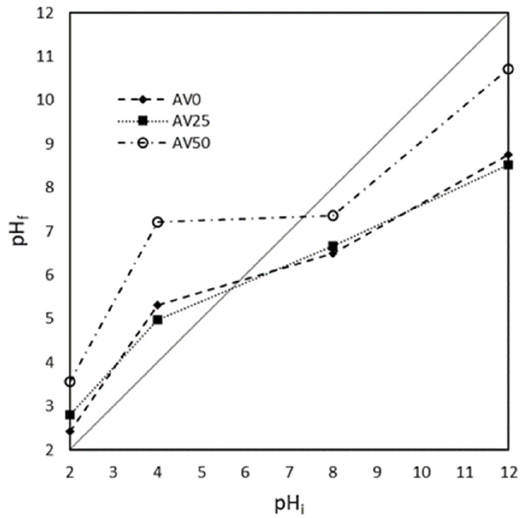
Figure 2. Zero-point charge (pHZC) determination for AV0, AV25 and AV50. The zero-point charge is represented by the intersection of the characteristic lines for all the samples with the bisector of the graph.